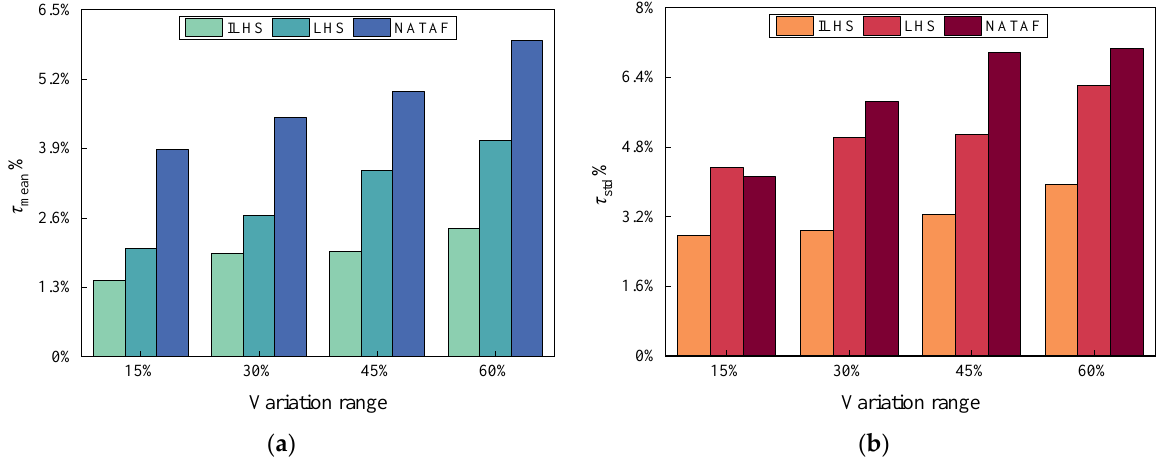
Figure 12. Comparison of ( a ) the mean error and ( b ) the standard deviation error of the AC bus voltage phase angles under different fluctuation ranges of each load.